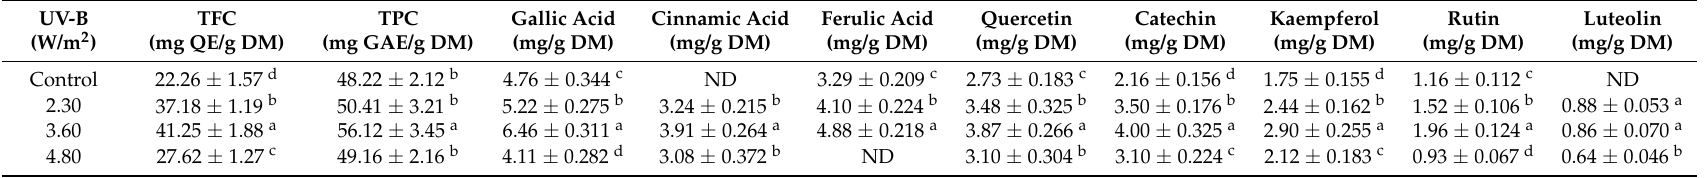
Table 1. Effect of UV-B irradiation on TFC, TPC and individual flavonoid and phenolic acids content from sweet basil leaf extracts.